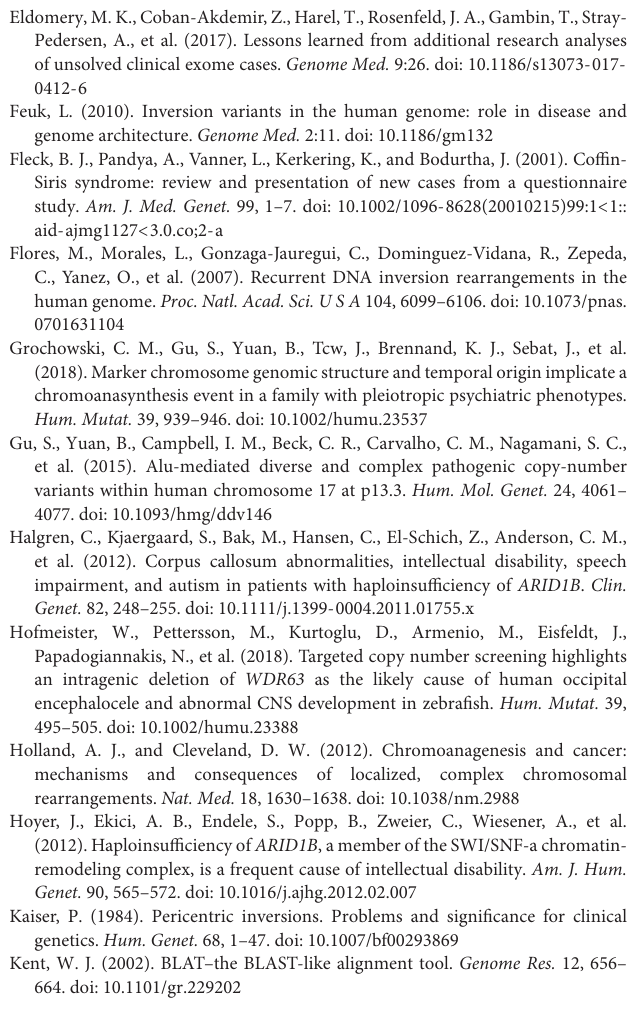
Supplementary Figure 14 | Genomic optical mapping data for junction 4 showing the connection of Chr6:158,471,518 and Chr6:160,535,951 in an inverted orientation. Supplementary Figure 15 | Genomic optical mapping data with single molecule visualization for junction 5. The connection at Chr6:158,471,518 is which is represented by the purple arrow in a tail-to-tail orientation with Chr6:157,240,708 which is represented by a red arrow. Supplementary Figure 16 | Genomic optical mapping data showing junction 6 with the connection of Chr6:159,359,468 which is represented by a yellow arrow fused to Chr6:160,535,951 represented by a gray arrow connected in a tail-to-tail orientation. Supplementary Figure 17 | Graphical representation of the exons forming ARID1B as well as the position of the inversion breakpoint disrupting the gene as denoted by the red vertical line between the 4th and 5th exon. Supplementary Figure 18 | Out of the 6 breakpoints that occurred on this chromosome, four occurred within the genes including ATXN1 , CDK19 , ARID1B , and SYNJ2 . Supplementary Table 1 | TIDDIT genome-wide structural variant calls for the proband. Yellow highlights denote the variants involved in this complex